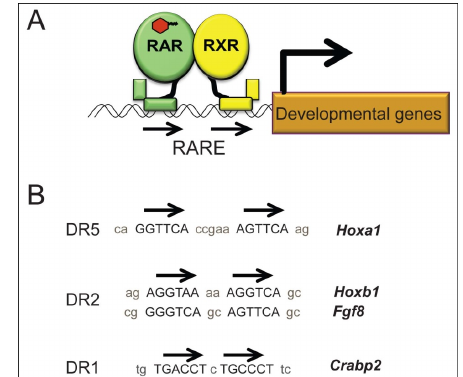
Figure 2. Canonical RA signaling activity occurs when RA regulates gene transcription by binding as ligand to RAR nuclear transcription factors at RARE sites. ( A ) RARs function as heterodimer with RXRs. Binding of RA (represented by orange hexagon) to the ligand-binding domain of a RAR heterodimerized with a RXR can activate transcription; ( B ) RAR–RXR heterodimers bind to DNA at RARE sites. Examples of classical RARE binding sites consist of two directly repeated hexamer motifs separated by spacer nucleotide sequences of different lengths. Examples of DR5, DR2, and DR1 RAREs from important RA-regulated developmental genes are